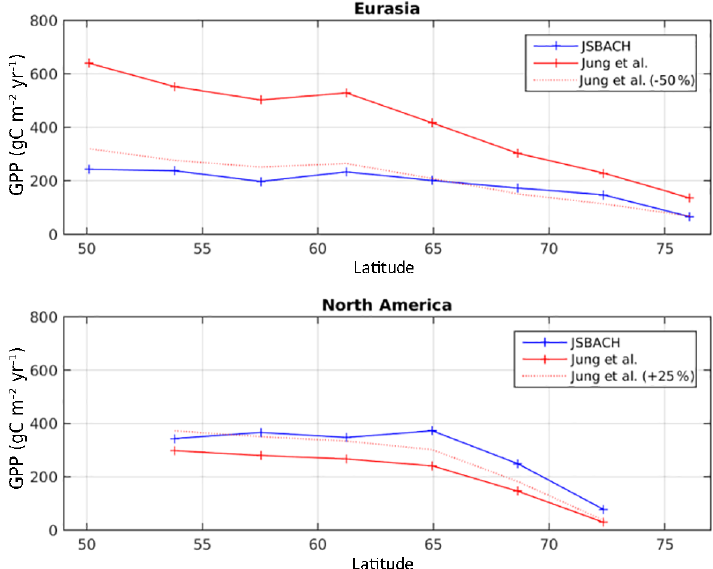
Figure A4. Simulated and observed high-latitude GPP for Eurasia and North America. Model results are for pre-industrial conditions. Observations are from Jung et al. (2011) and scaled to 85% to account for lower pre-industrial GPP (Ciais et al., 2013). Regional zonal averaging was only performed for grid cells containing near-surface permafrost.